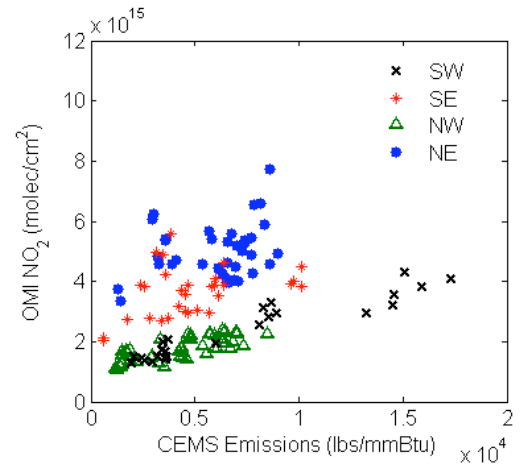
Fig. 4. Average summertime CEMS emissions versus OMI NO 2 column density for 2005–2011 for each power plant analyzed here. Symbols show the locations of the power plants by quadrant of the US (NW: northwest, SW: southwest, NE: northeast, SE: